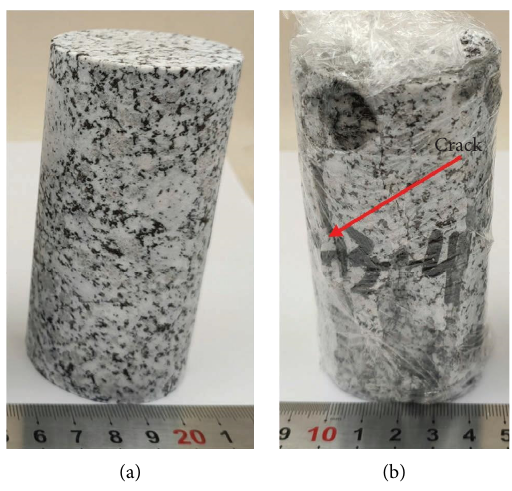
Figure 11: Intact and damaged rock samples.